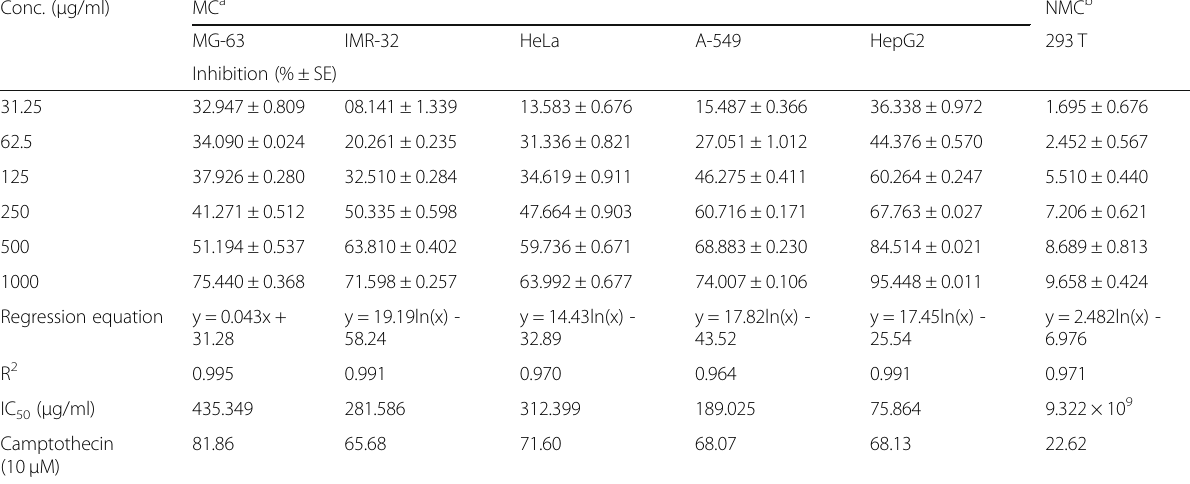
Table 7 Percentage growth inhibitory effect of herbal combination against different human cell lines Conc. ( μ g/ml)